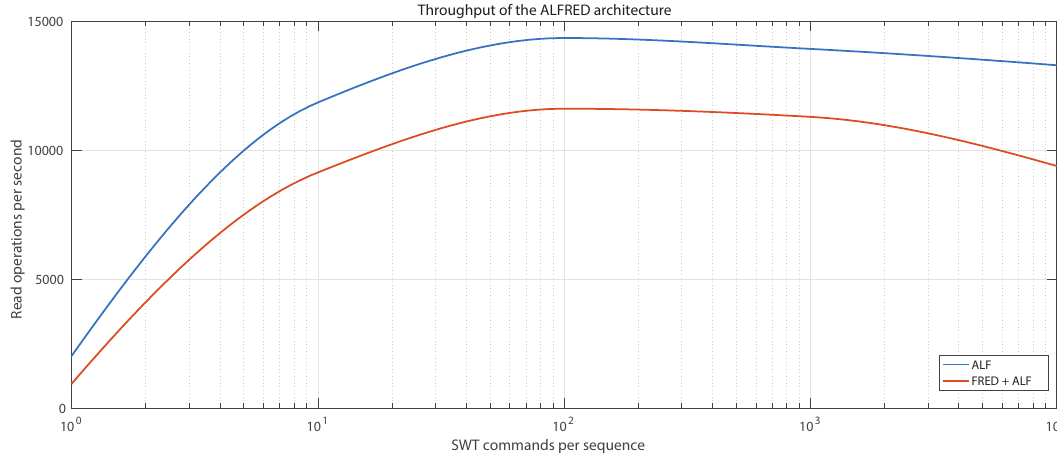
Figure 7. Throughput of read operation using ALFRED